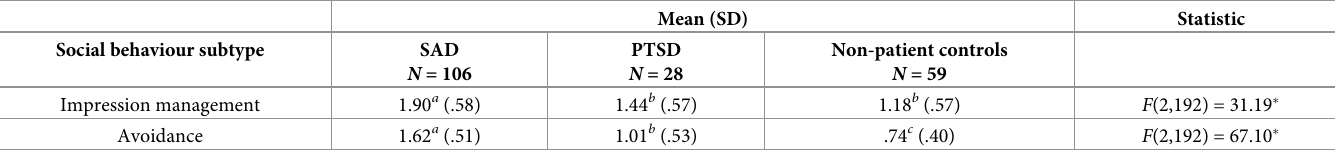
Table 4. Differences between groups in the use of impression management and avoidance safety